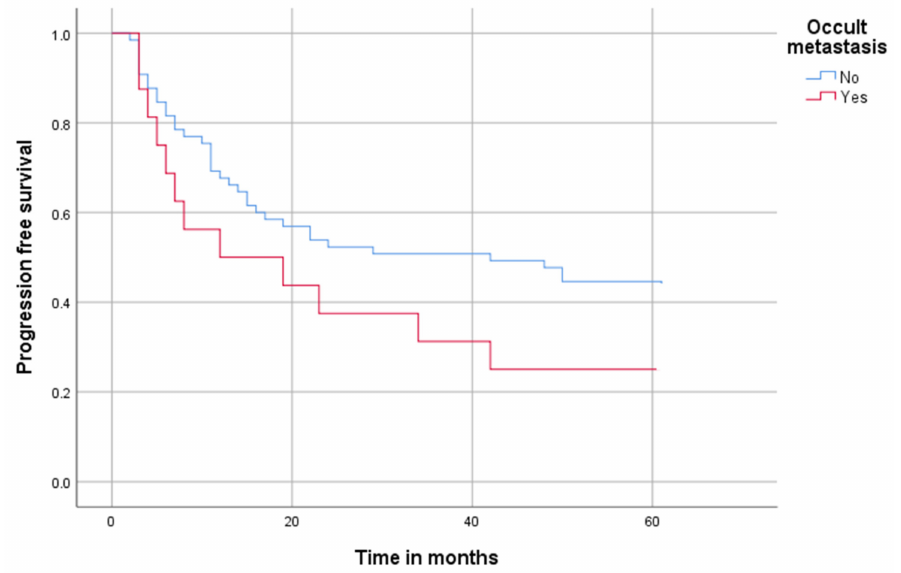
Figure 2. Progression-free survival in all N+ patients, occult metastasis yes vs. no. Progression-free- survival in all N+ patients over 60 months; blue marks patients without occult metastasis (but prior diagnosed metastasis via staging; red marks patients with occult